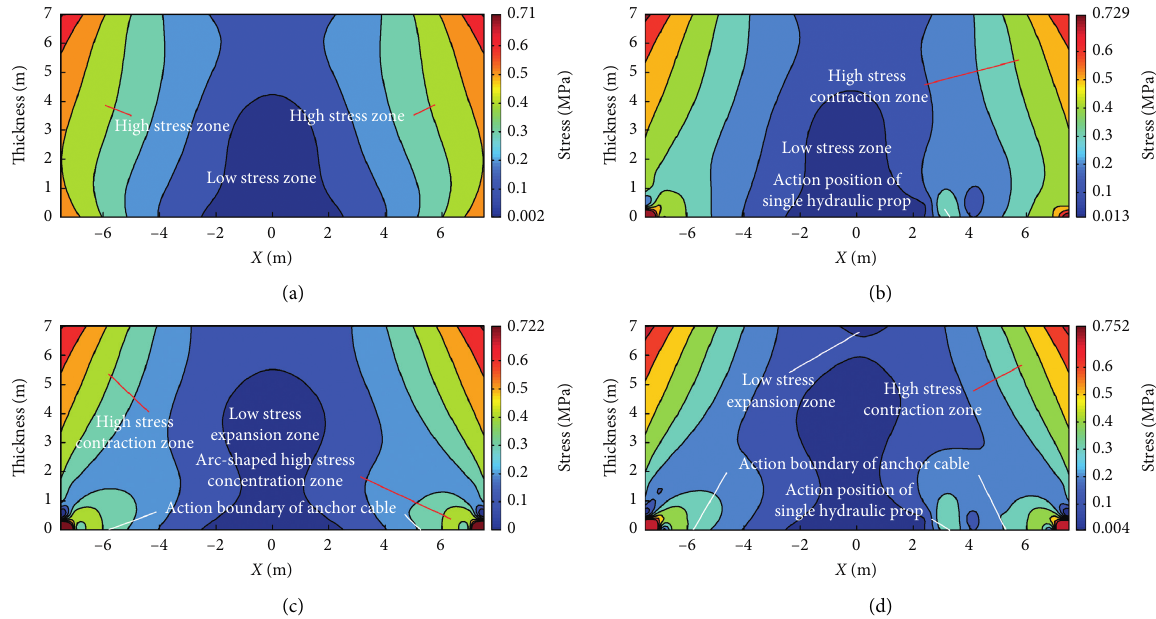
Figure 14: MSS distributions in ARBBS under the functions of roof load, single hydraulic prop, and anchor cables. (a) Function of q . (b) Functions of q and F . (c) Functions of q and p . (d) Functions of q , F , and p . Table 3: Area ratios of low stress zone and high stress zones in ARBBS under the functions of different influencing factors. Function of influencing